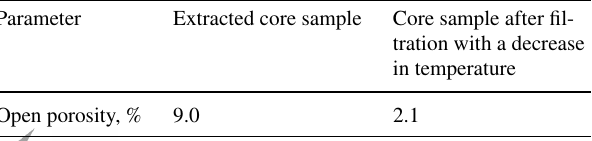
Fig. 5 3D models of the core segment ( a the extracted and dried sample; b the sample after filtration of a wax-bearing solution with a decrease in temperature) Table 1 The porosity of the core sample according to micro-com- puted tomography